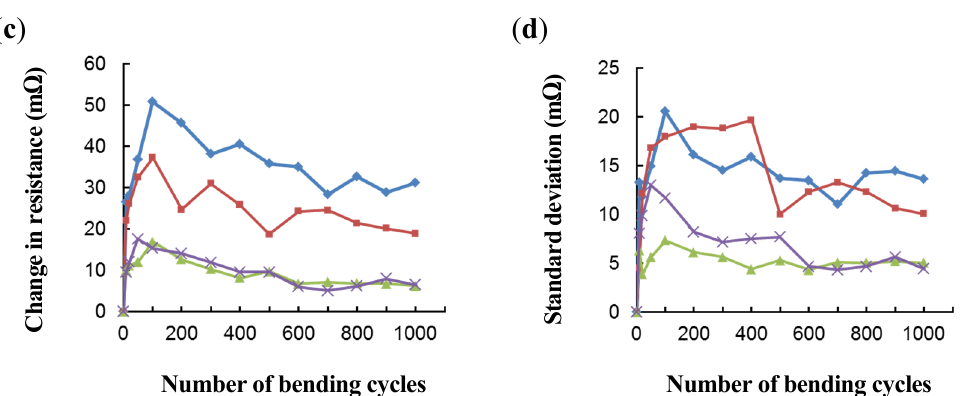
Figure 12. Change in resistance during the bending test for a curvature radius of 50 mm: ( a , b ) continuous measurements and ( c , d ) intermittent measurements.